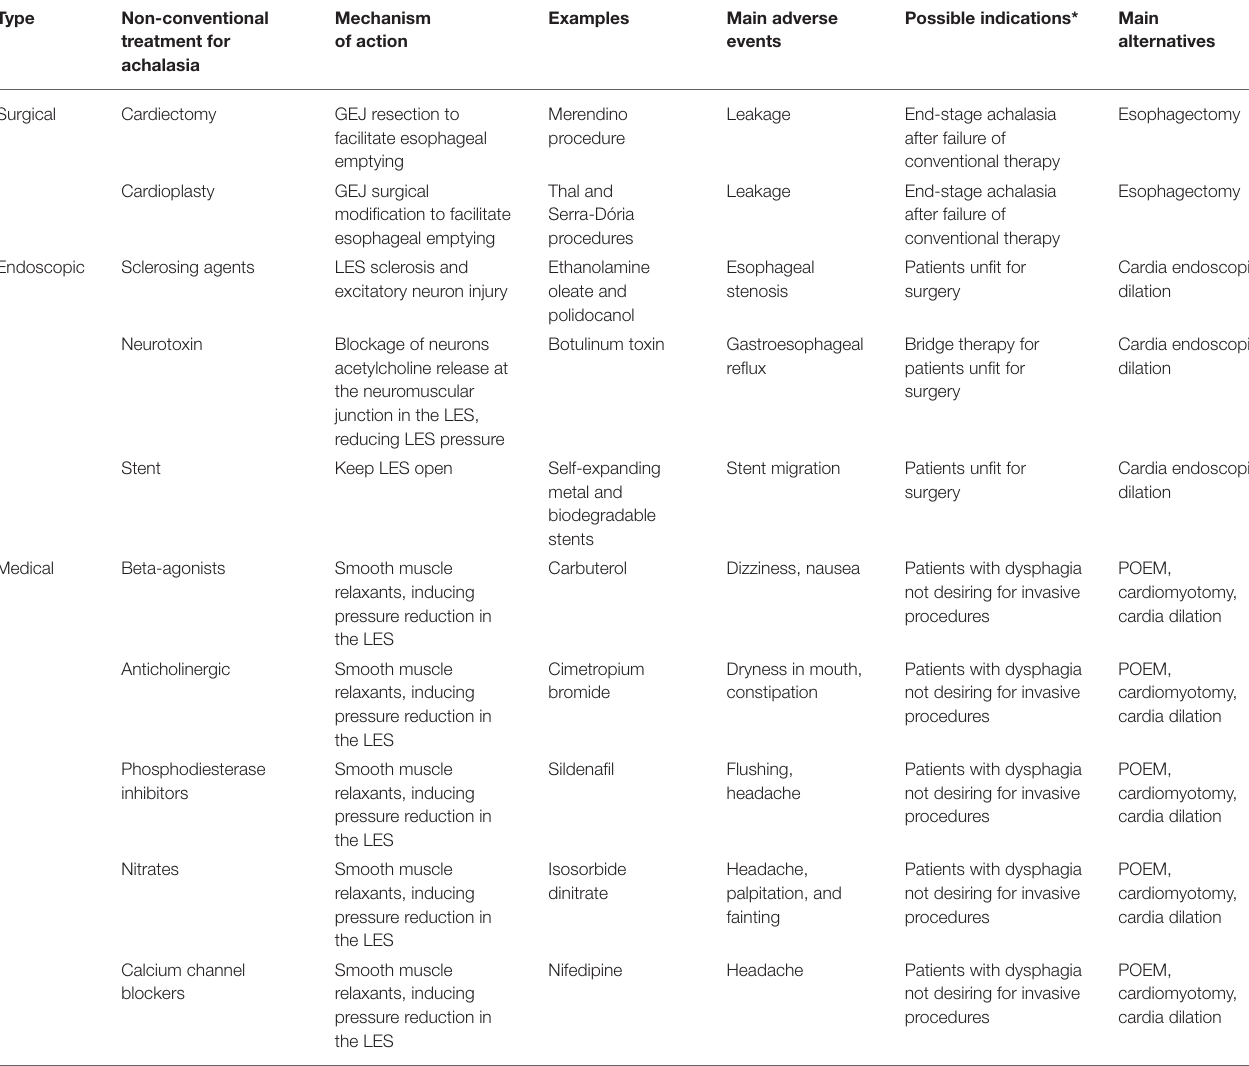
TABLE 3 | Summary of the main non-conventional therapy for achalasia.